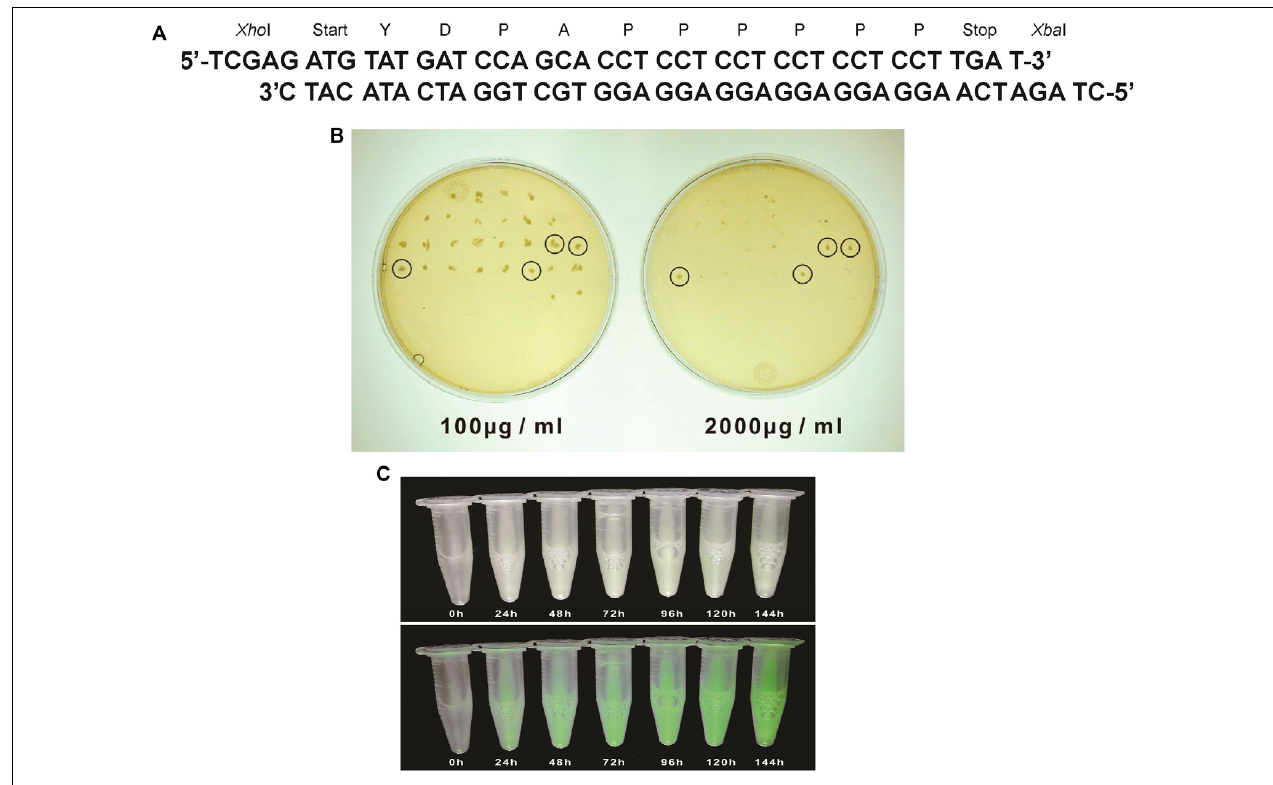
FIGURE 2 | (A) A synthetic tmf A made up of 2 oligonucleotides that were annealed and used for cloning tmf A into pPICZB. The two restriction site positions Xho I and Xba I and start and stop signals and the amino acids sequence of TMOF are also shown. (B) YPDS agar plates to select transformed KM71H- tmf A for high copy number and low copy number on Zeocin (100 µ g/ml and 1000 µ g/ml, respectively). Only 4 colonies survived in the presence of high Zeocin concentration, whereas many colonies survived at low Zeocin concentration. (C) KM71- gfp-tmf A engineered cells that were fermented by shake flask for (0–144 h). Cells that were exposed to regular light (upper panel) did not fluoresce, whereas cells that were exposed to UV light (lower panel) increased in fluorescence as the fermentation